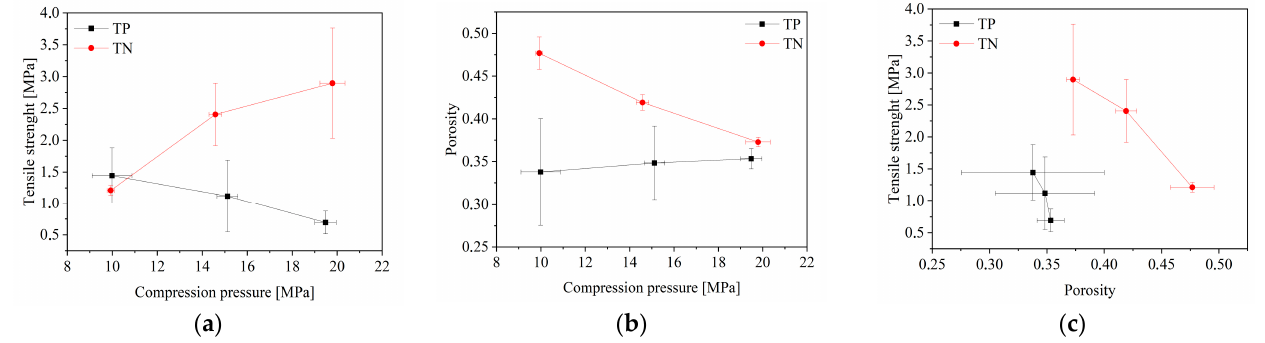
Figure 1. Tabletability ( a ), compressibility ( b ), and compactibility ( c ) profiles of tablets produced from nanofibers (TN) and powder (TP).